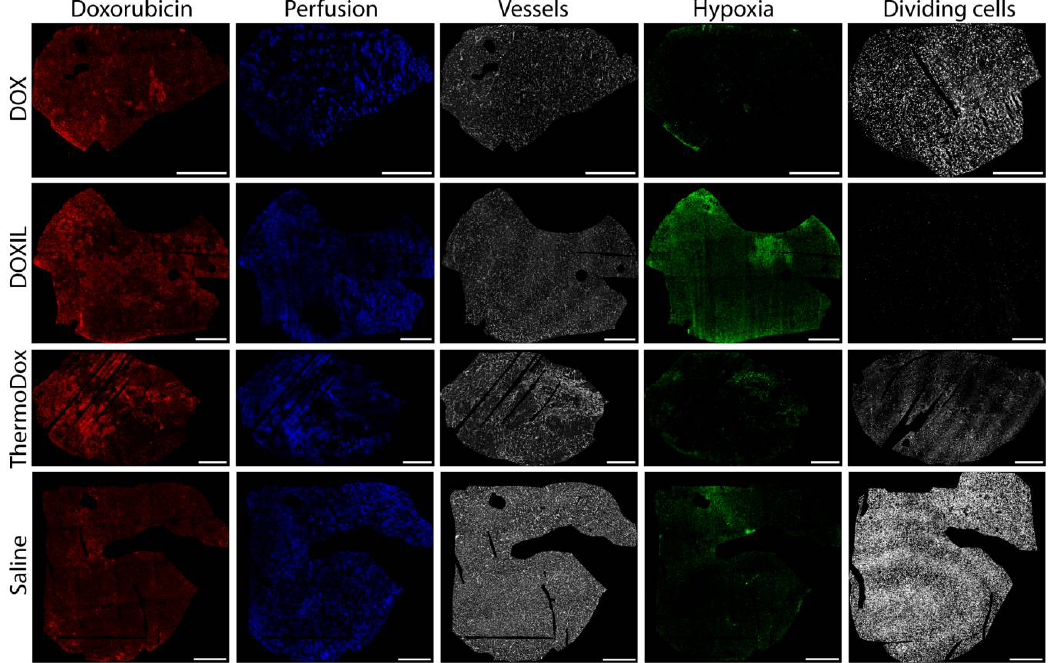
Figure 2 . Different stainings of tumors treated with 5 mg/kg DOX, DOXIL, and ThermoDox. Tumors Figure 2. Di ff erent stainings of tumors treated with 5 mg / kg DOX, DOXIL, and ThermoDox. stained for doxorubicin, perfusion, all vessels, hypoxia, and proliferating cells. The scale bar is 1 mm.